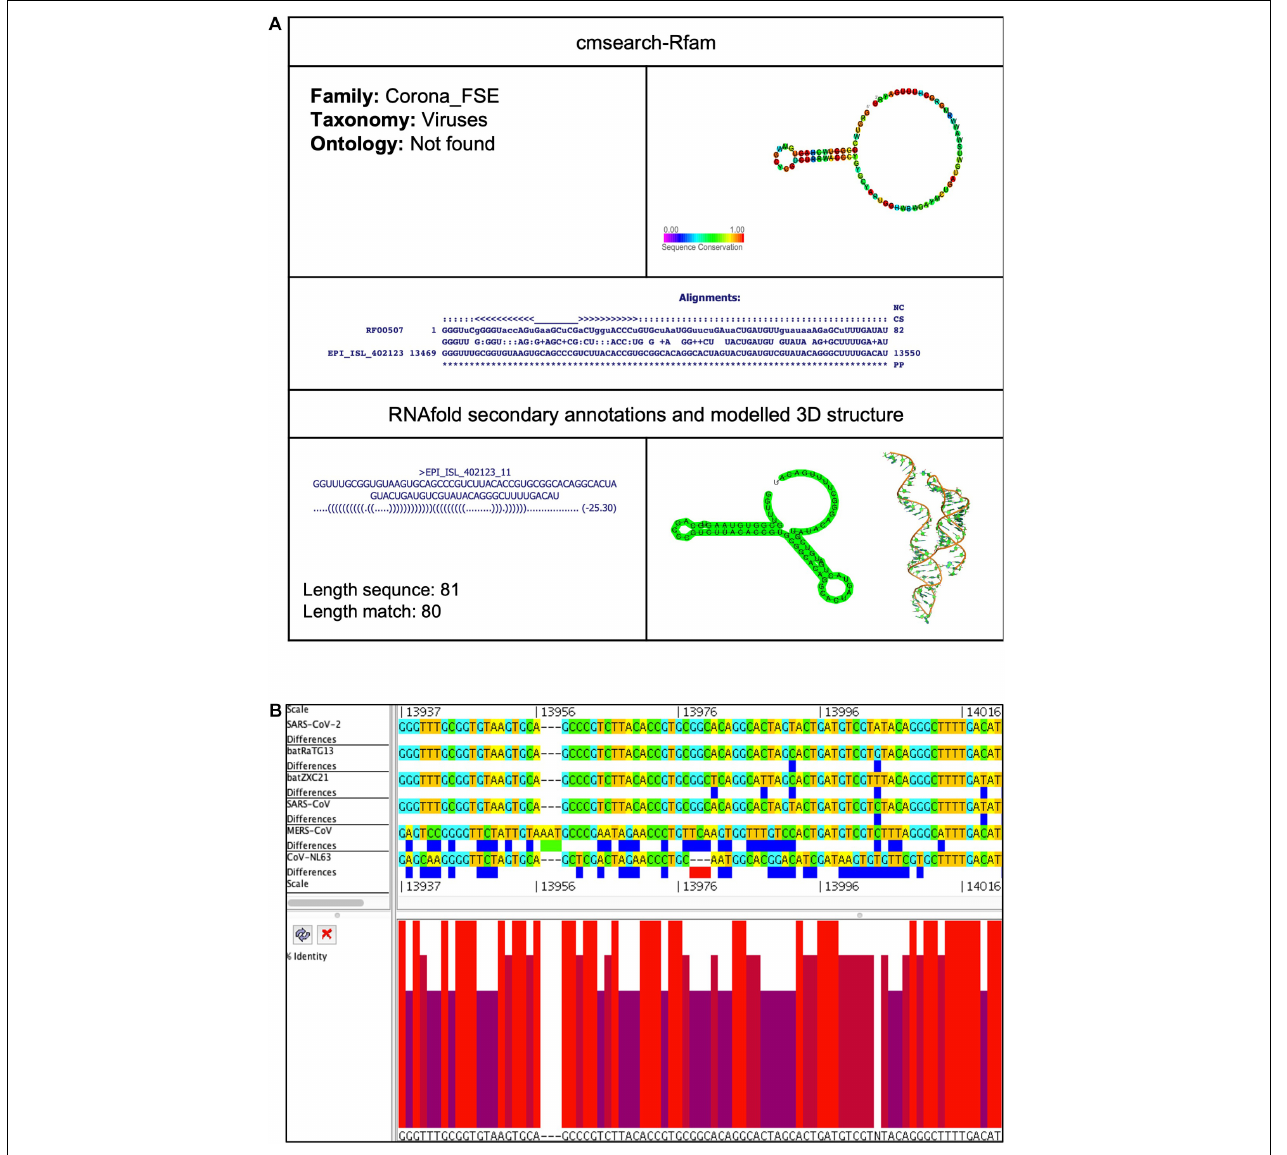
FIGURE 3 | Corona_FSE cis -acting RNA element in the SARS-CoV-2 genome. (A) The sequence and RNA structure of Corona_FSE is located in position 13,469–13,550 of the SARS-CoV-2 genome. In the 3-D structure, the phosphodiester backbone is shown in orange, and the nucleotides are shown in the sticks and filled rings with elemental coloring as C green, O red, and N blue. (B) Conservation of Corona_FSE RNA sequence from various CoVs. The Corona_FSE is located as aligned position 13,937–14,021. The navy blue box indicates mismatched nucleotides between the two sequences, and the red box shows gaps between two sequences. Percentage identity in the histogram in which red indicates a perfect match and magenta shows the low similarity of